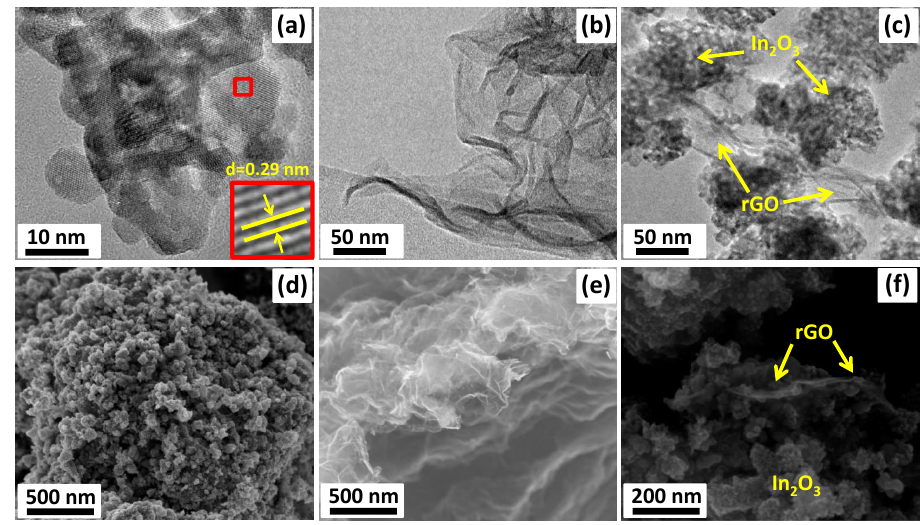
Figure 2. TEM images ( a – c ) and SEM images ( d – f ) of the In 2 O 3 ( a , d ), rGO ( b , e ), and In 2 O 3 /rGO composite ( c , f ).